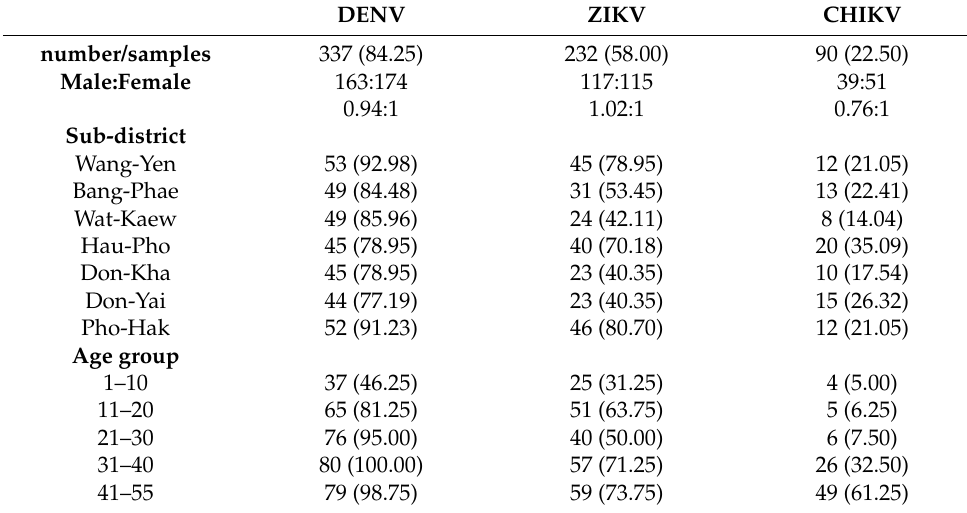
Table 2. Seropositivity to three arboviruses according to ELISA [ n (%)].